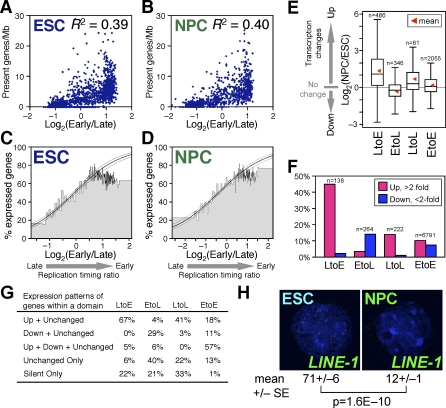
Replication Timing and Transcription Changes during Differentiation(A and B) Average replication-timing ratios of replication domains were plotted against their “present” (i.e., transcriptionally active) gene density for ESCs (A) and NPCs (B). Pearson R
2 values are shown.(C and D) Correlation between early replication and the probability of expression. Genes were ranked by their replication-timing ratio and divided into bins of 100 genes, the height of which represents the percentage of active (i.e., ”present”) genes within each bin. The width and position of each bin represents its range of replication-timing ratios. Logistic regression (inner line) and 95% confidence intervals (outer lines) reveal a clear correlation in both ESCs (C) and NPCs (D). By the Likelihood Ratio test (a goodness-of-fit test), the fitted model is significantly different (p < 2 × 10−16 for both ESCs and NPCs) from that of a null hypothesis in which replication timing has no correlation to transcription.(E) Box plots showing the fold changes in transcription [i.e., log2(NPC/ESC)] of LtoE, EtoL, LtoL, and EtoE genes. RefSeq genes with the 5% greatest replication timing changes were defined as EtoL and LtoE, whereas those with the least changes (lowest 20%) that maintained replication timing ratio of above 0.5 or below −0.5 were defined as EtoE and LtoL, respectively.(F) Percentage of 2-fold up- or down-regulated genes within LtoE, EtoL, LtoL, and EtoE domains defined in Figure 4G.(G) Summary of expression patterns of genes within LtoE, EtoL, LtoL, and EtoE domains. Definitions are as follows: “Up” and “Down,” above 2-fold up- and down-regulation, respectively; “Unchanged,” below 2-fold up-/down-regulation; “Unchanged Only,” domains with both active and silent genes that do not change by 2-fold; and “Silent Only,” domains with only silent genes in both states.(H) LINE-1 transposable elements are actively transcribed in ESCs but become inactive in NPCs as assayed by RNA-FISH. Mean and standard error of mean (SEM) of the number of RNA-FISH signals per nucleus is shown (n = 30 from two biological replicates). The p-value was obtained from a two-tailed t-test for comparison of two unpaired groups.